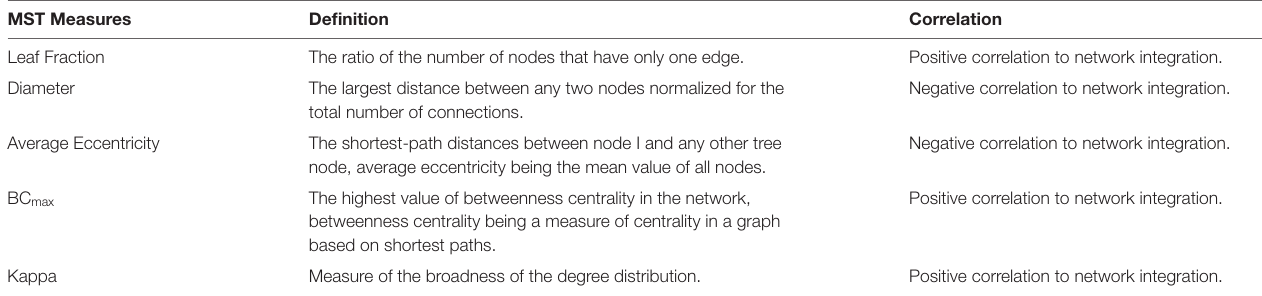
TABLE 1 | Definitions of five minimal spanning tree (MST) variables for EEG brain